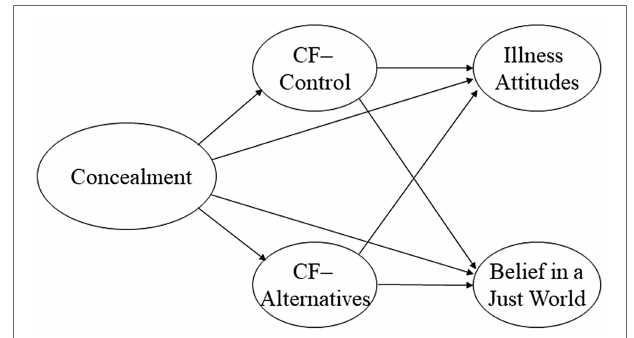
FIGURE 1 | Research